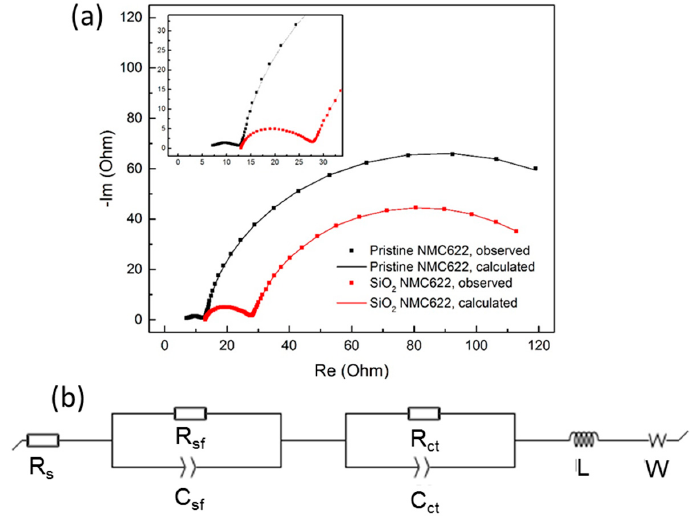
Figure 7. EIS measurements of the pristine and SiO 2 -coated NMC622: ( a ) Nyquist plots of both samples after 700 cycles and the fitting results; ( b ) the applied equivalent circuit model